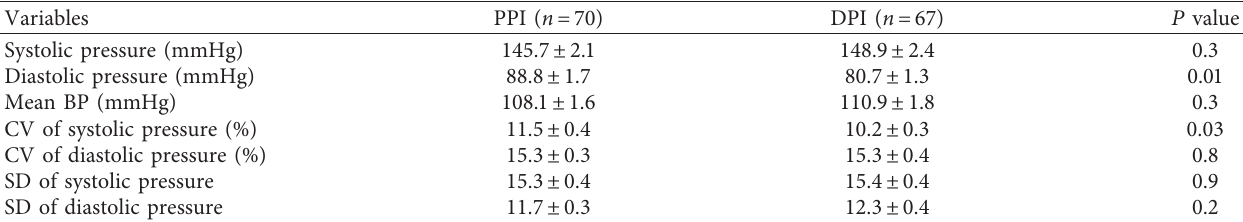
Table 3: Differences in BP variability between patients in the DPI and PPI